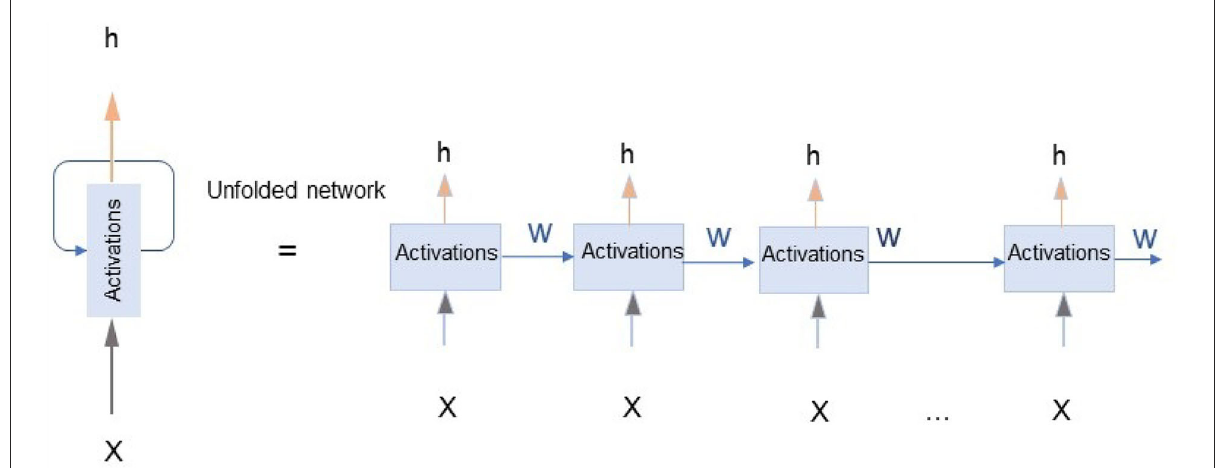
FIGURE4 The left diagram illustrates the recurrent neural network (RNN) with an infinite loop network, with the model outputs fed back as inputs. The right figure is an unfolded representation of an RNN with X: input, h: hidden state, or output of each unit (LeCun et al., 2015).